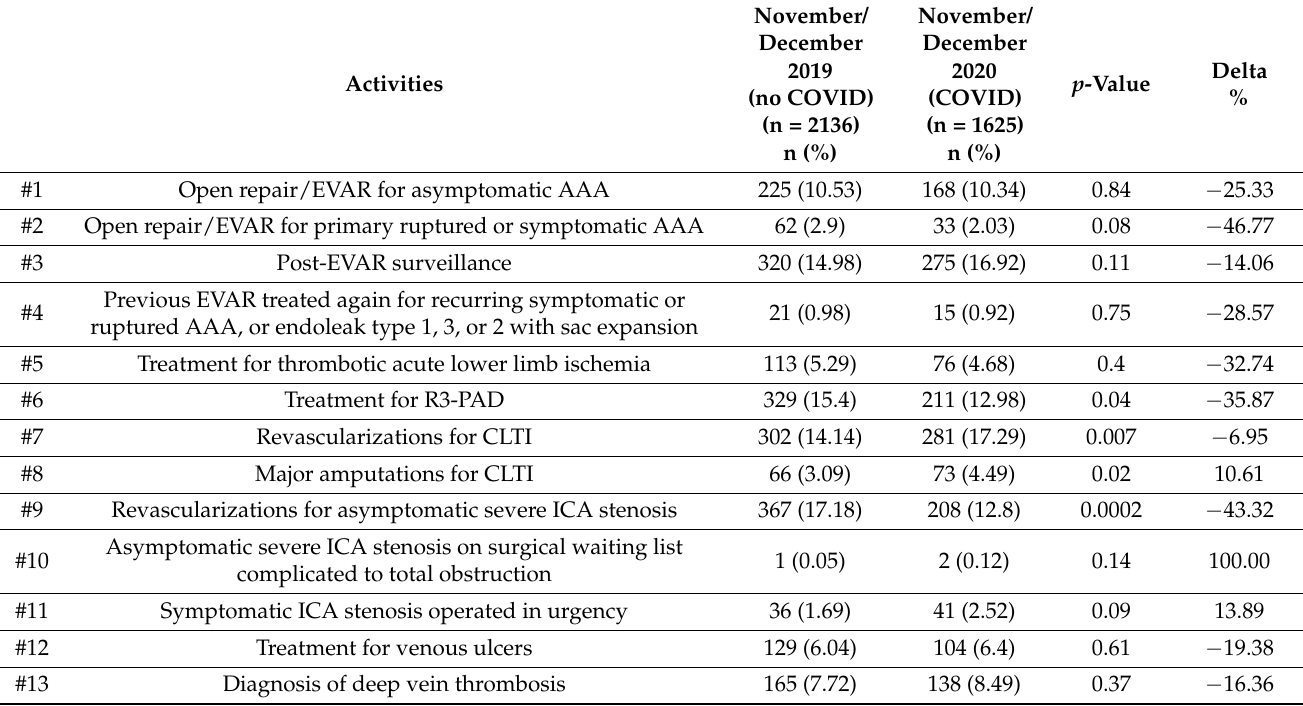
Table 7. Summary of the responses to the questionnaire for the COVID-19 months of Novem-